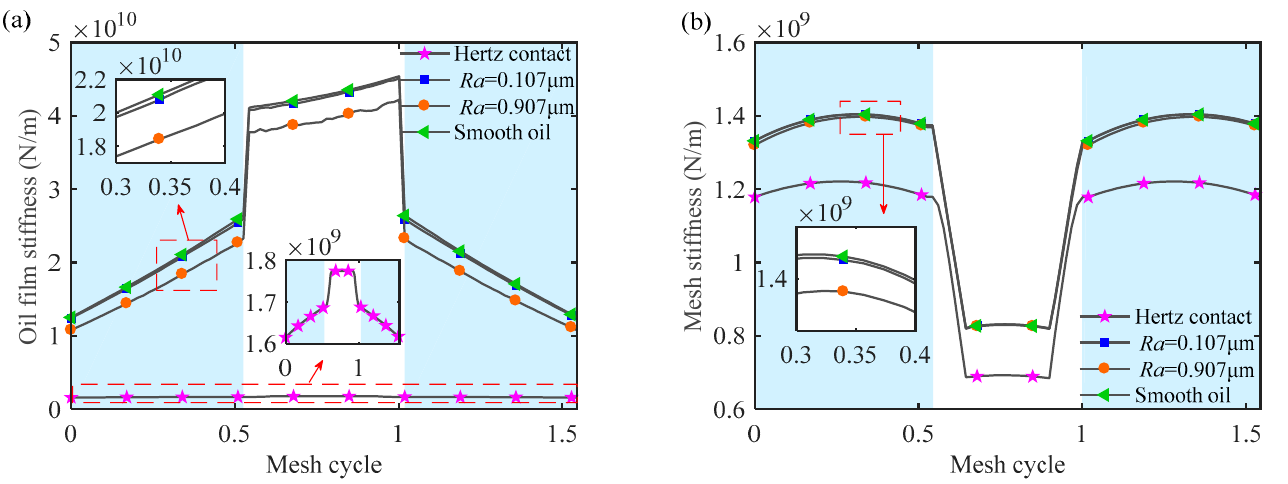
Figure 12. OFS and TVMS of gear under different contact modes: ( a ) OFS; ( b ) TVMS.